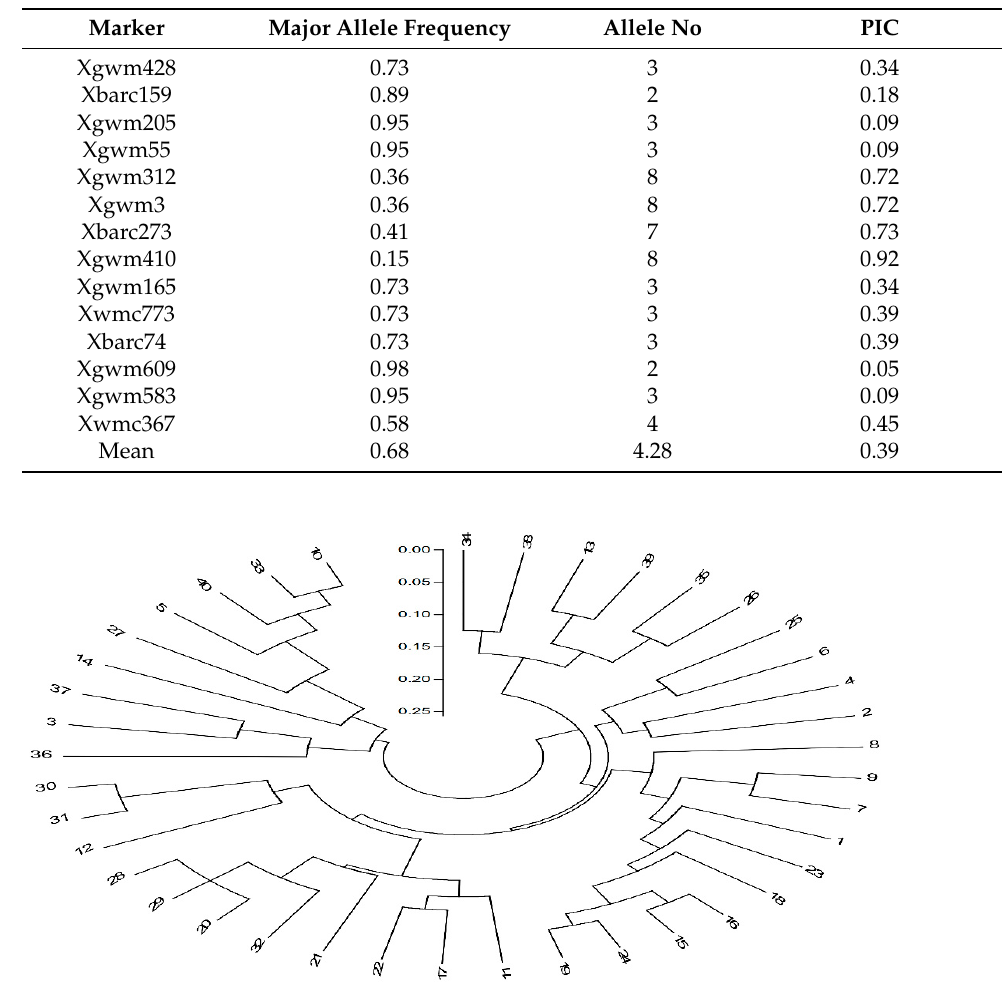
Figure 3. Phylogenetic tree illustrating the genetic relationships among the 40 Ae. tauschii populations collected in China based on the 14 SSRs marker.